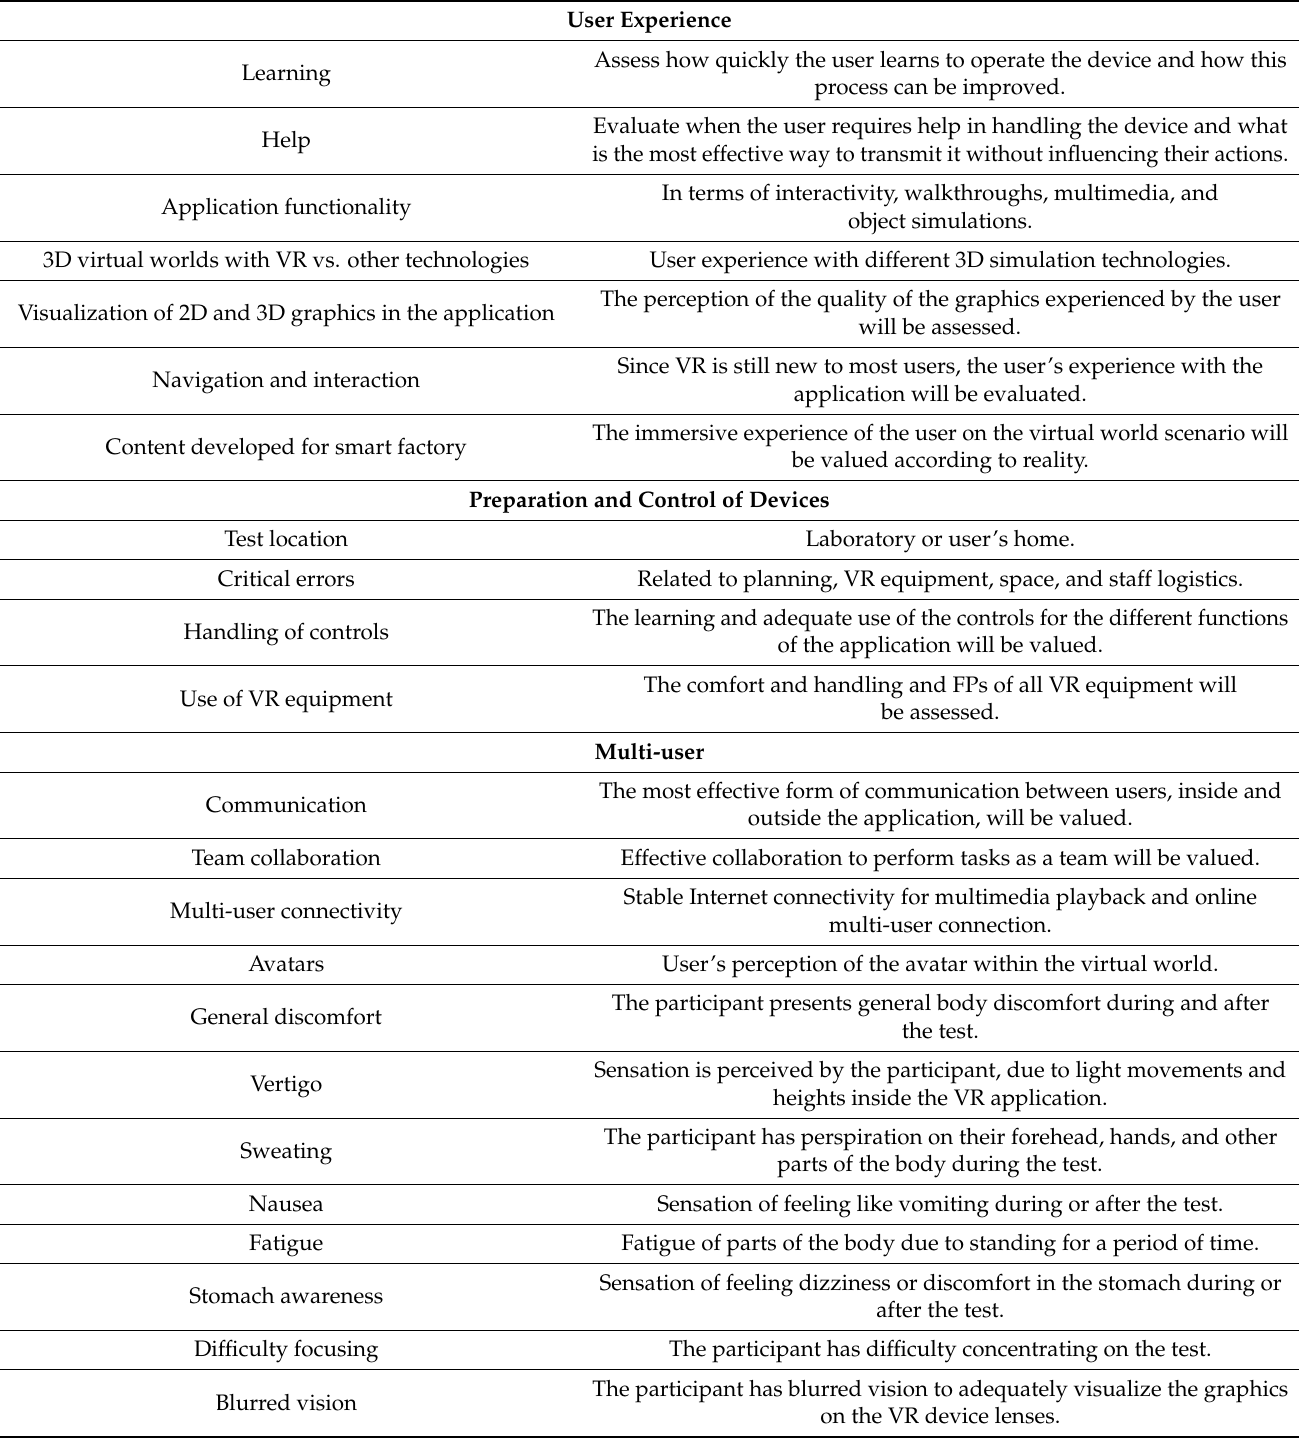
Table 4. Metrics definition using the VR